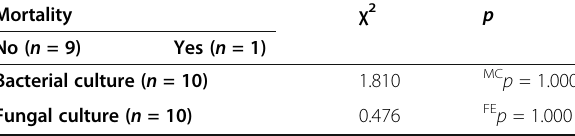
Table 5 Relation between mortality and different